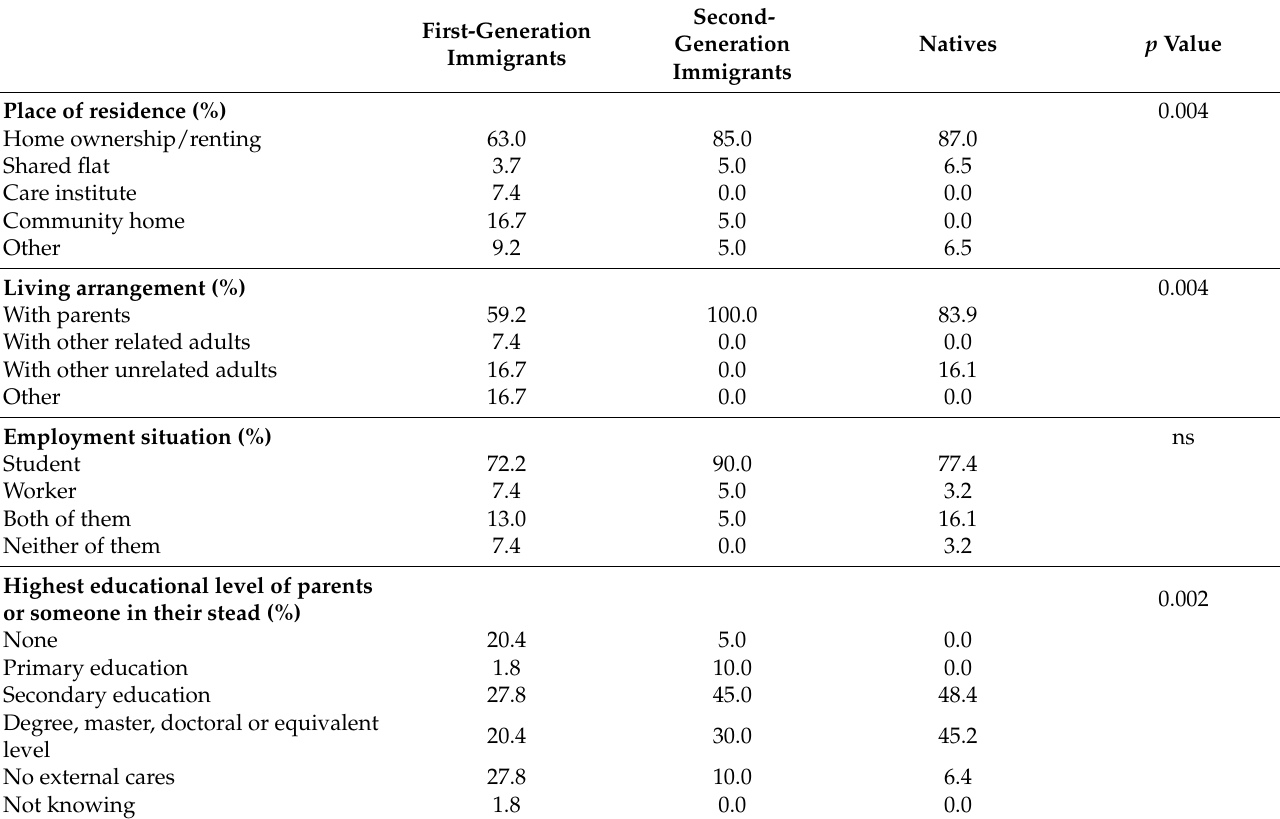
Table 4. Social aspects by migration